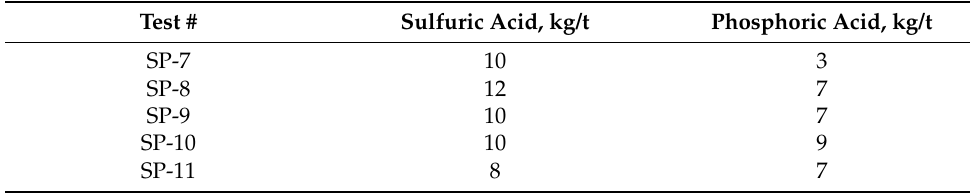
Table 6. Reagent dosages used in the reverse flotation of carbonate from the bulk skarn phosphate flotation concentrate.